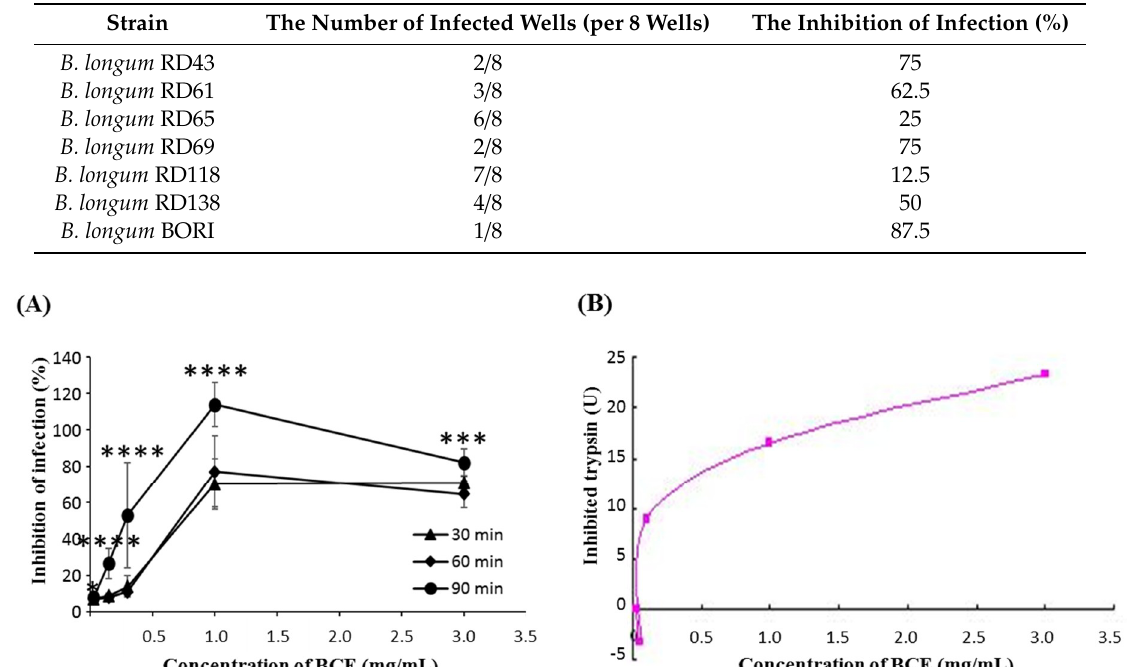
Figure 1. The effects of bacterial whole cell extract (BCE) on rotavirus infection. ( A ) BCE and rotavirus were incubated for 30, 60, 90 min together prior to treatment. The single, triple asterisk and quadruple asterisk indicate significant difference of the inhibitory effect of infection of BCE exposure to the cells among different time points (* p < 0.05, *** p < 0.001, **** p < 0.0001). Data are expressed as the mean ± SD ( n = 8). ( B ) Calorimetric trypsin inhibitor assay was performed with various concentrations of BCE.